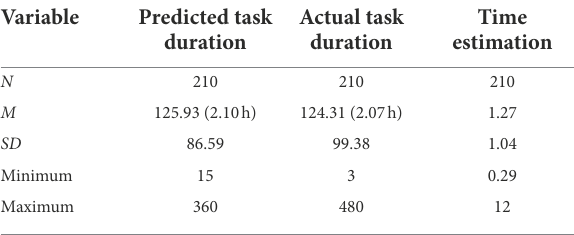
TABLE 2 Means, standard deviations, and range of minutes spent on tasks and time estimation ratios.